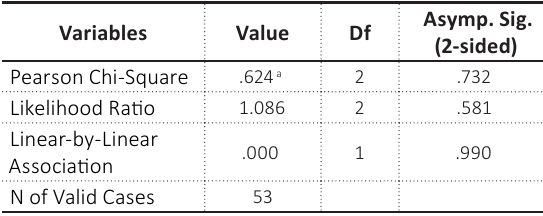
Table 4. Evaluation of the connection between the nature of the hospital (public and private) and the existence of persons responsible for clinical risk management